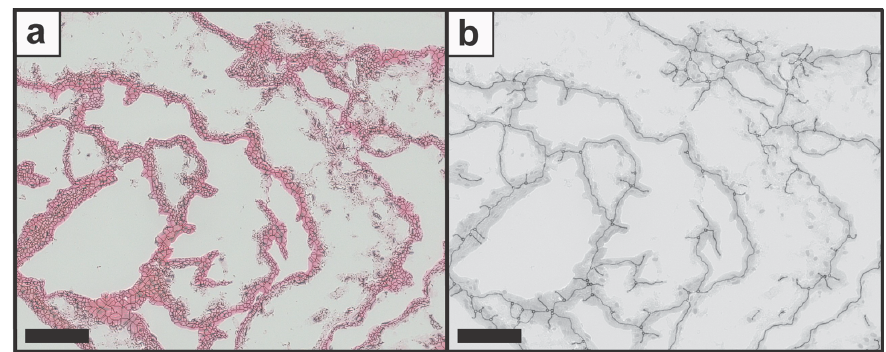
Figure 3. The original image was overlapped with ( a ) the skeleton structure as well as ( b ) the network structure image. Scale bars represent 100 µm.